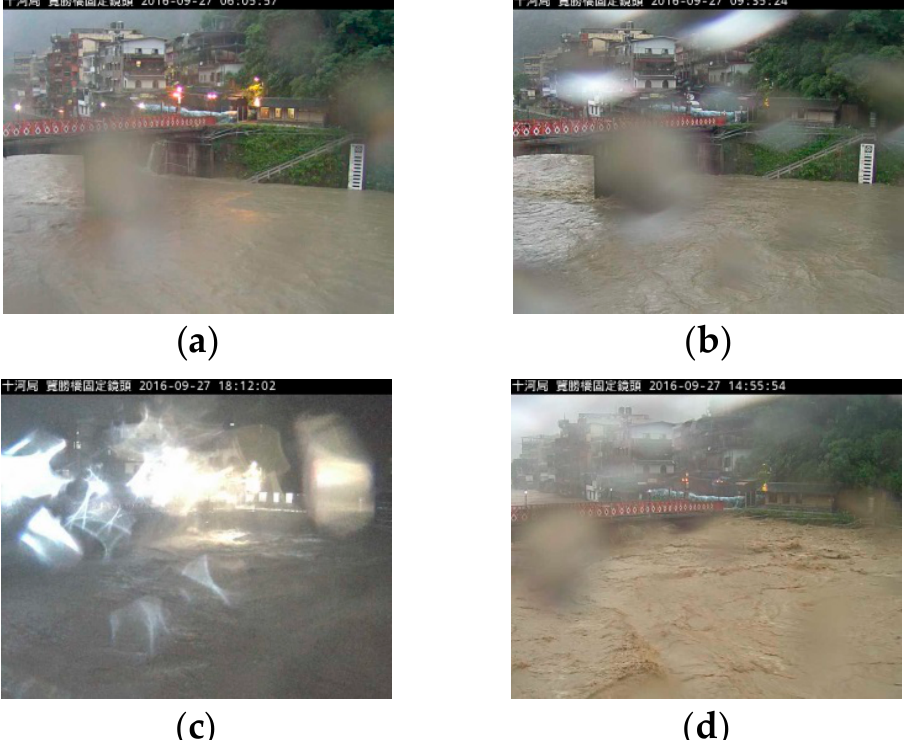
Figure 10. Images with false diagnoses. ( a – c ) The lens image was obstructed by water droplets. ( d ) The water level was out of the identification area.